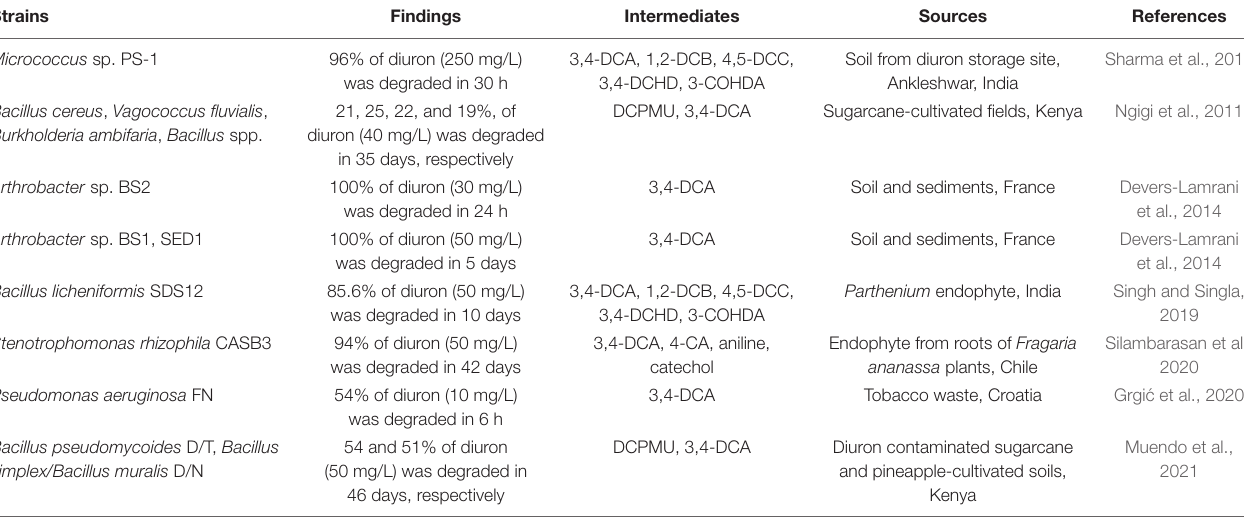
TABLE 1 | Newly isolated diuron-degrading bacteria.